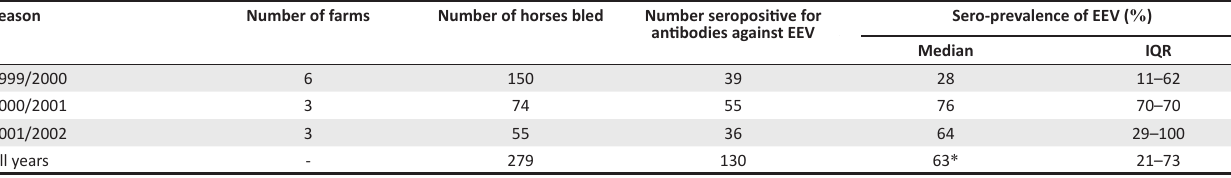
TABLE 1: The sero-prevalence of antibodies against equine encephalosis virus in horses in Zimbabwe, during three rainy seasons for the period 1999–2002. Season Number of farms Number of horses bled Number seropositive for